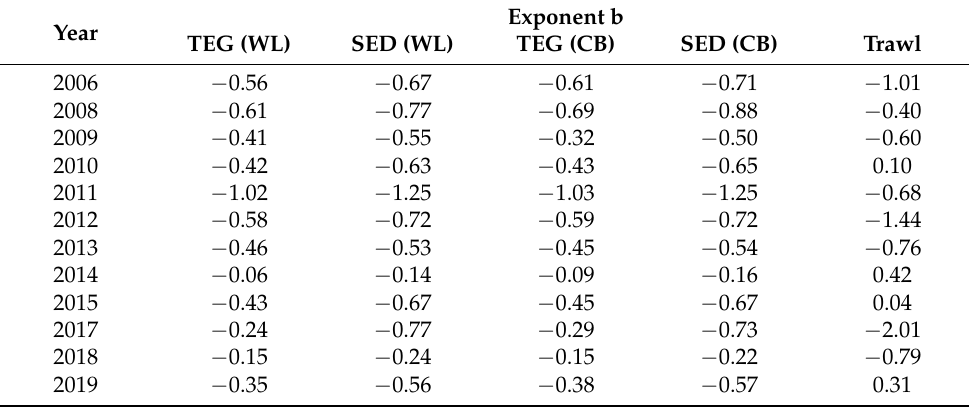
Table A1. Exponent b from maximum likelihood estimation for each method, including hydroacous- tics based on single-echo detection (SED) and tracked-echo groups (TEGs) of fish between 1–50 g body weight for 2006–2019 (excluding 2007 and 2016) from transects of the whole lake (WL) and the central basin (CB)